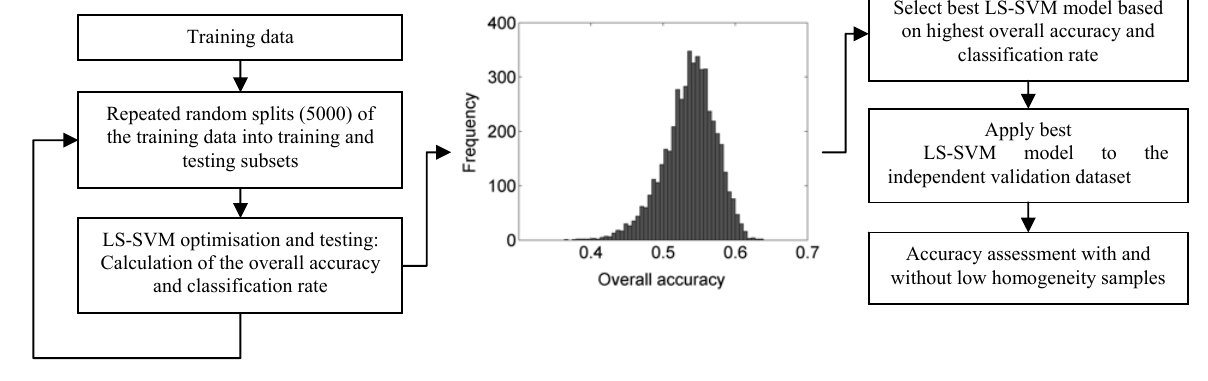
Figure 8. The schematization of the LS-SVM training, testing and validation process. The best set of support vectors was selected using an iterative approach with repeated random splits of the training data into multiple training and testing subsets. For each iteration, the LS-SVM was trained with the candidate support vectors (training subset), and the accuracy and classification rate were assessed using the testing subset. The best LS-SVM model was selected from the 5,000 candidate models according to the highest overall accuracy and the best classification rate. This model was applied to the validation dataset for accuracy